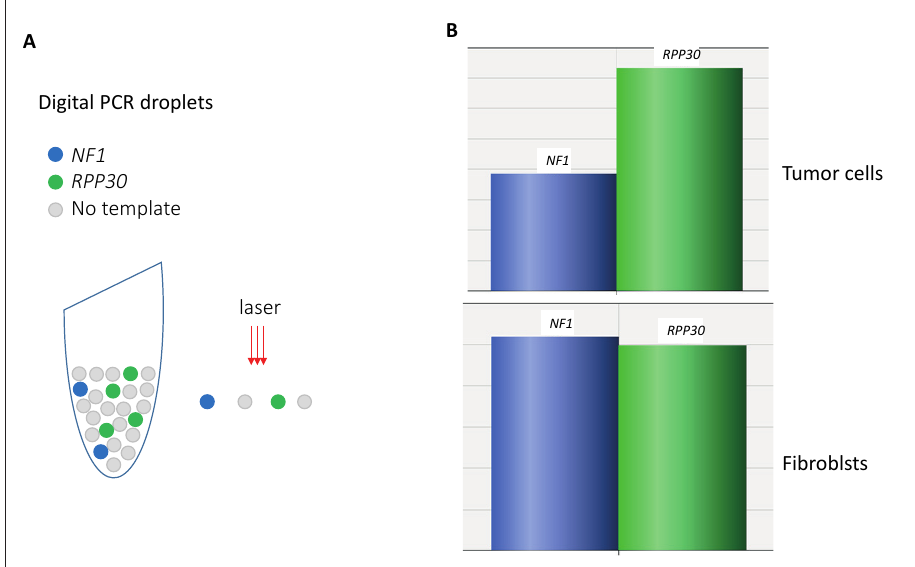
Fig. 2. Digital PCR. Illustration of the principle.